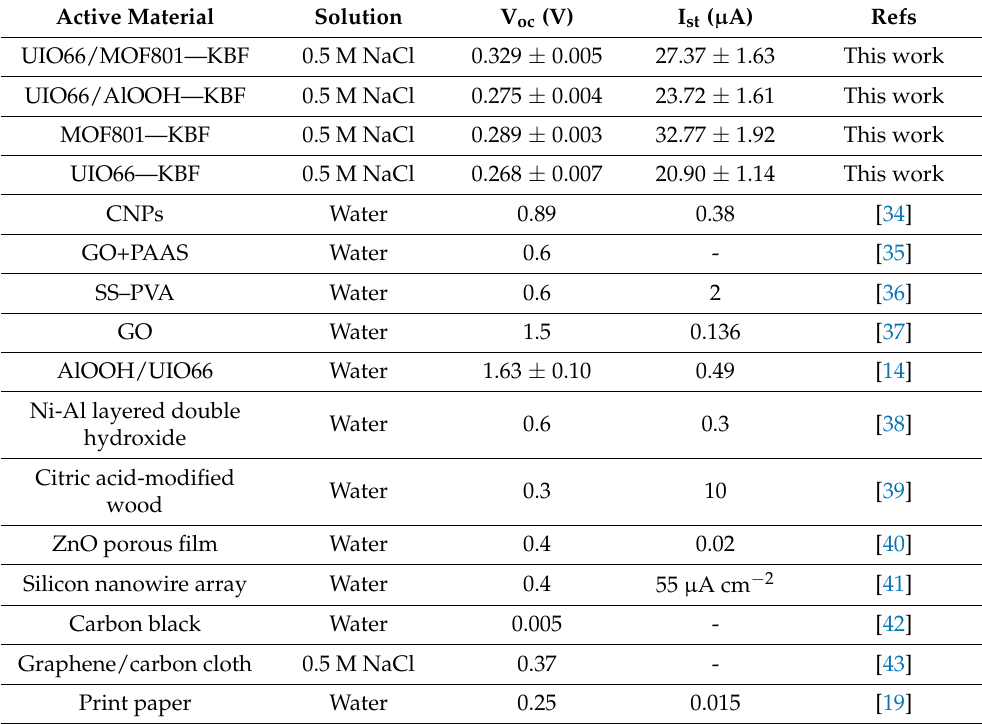
Table 1. Configuration and performance comparison of various evaporation-driven power